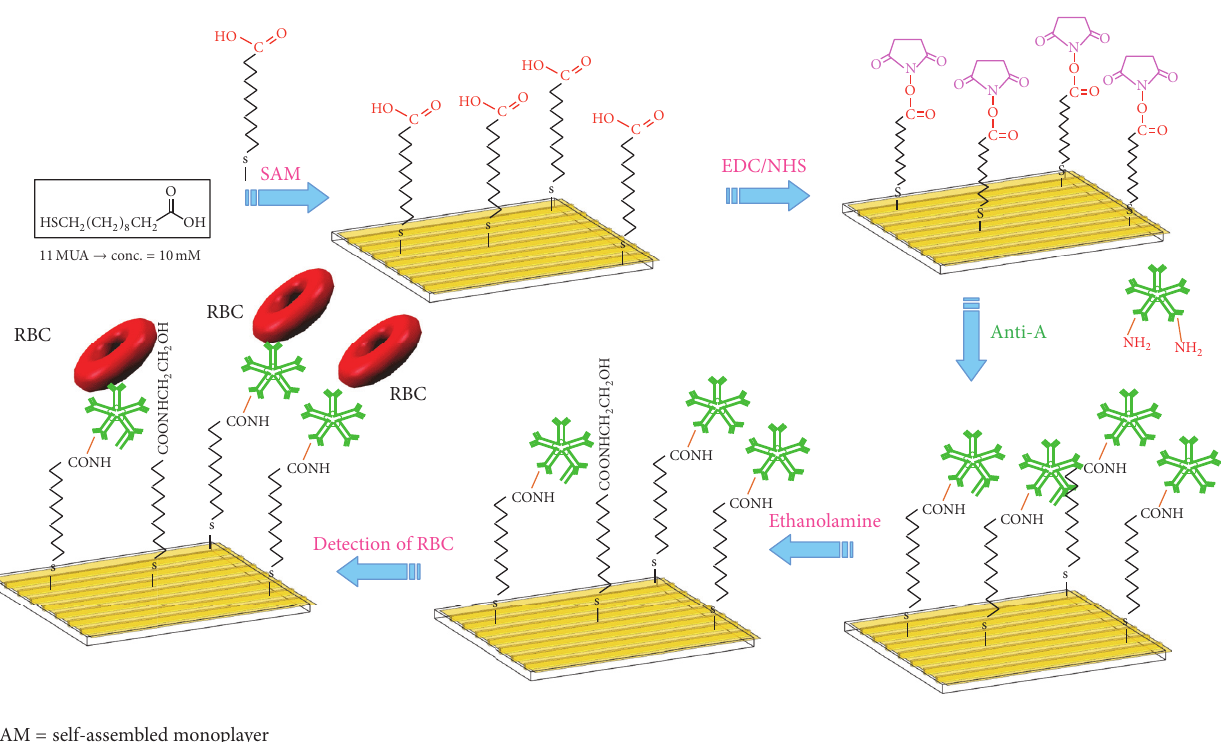
Figure 2: Schematic representation of immobilization of antibodies (Anti-A/Anti-B) and detection of red blood cells (RBCs).